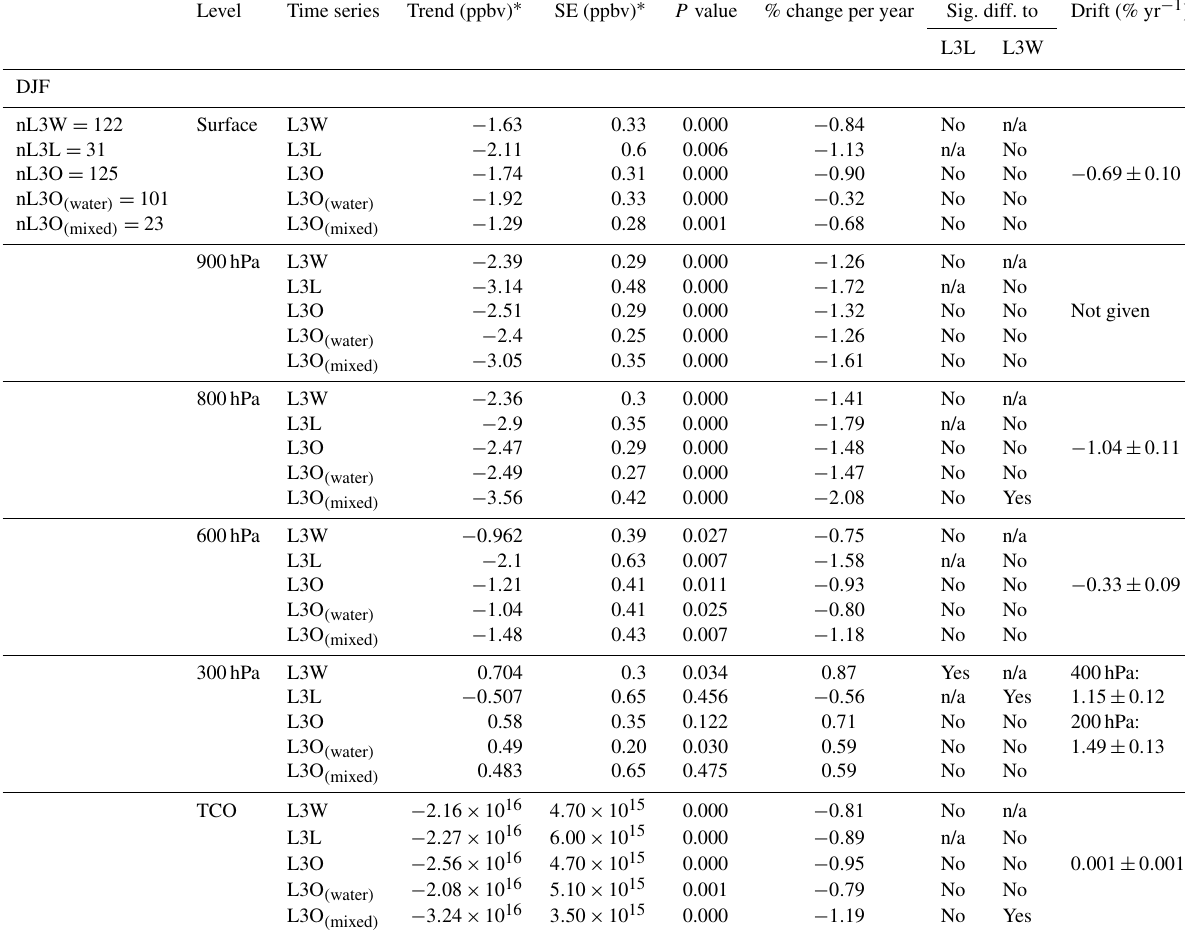
Table 3. Results from WLS regression analysis of seasonal mean L3W, L3L, L3O, L3O ( water ) and L3O ( mixed ) time series for selected profile levels in DJF and JJA. Trend corresponds to the gradient of the WLS best-fit line; SE is the standard error of the trend; P value is the probability that the trend is zero; % change per year is the mean percentage change in retrieved CO per year, calculated from WLS (cid:110)(cid:104)(cid:16) Predicted (cid:17) (cid:105) (cid:111)(cid:14) · 100 − 100 last regression model predicted values as follows: %change per year = ny , where ny is the number of years. Predicted first The penultimate two columns correspond to the result of a significance test performed on the difference between that row’s trend and the , where SE 1 and SE 2 correspond to the standard errors of Trend 1 and trend in L3L and L3W, respectively, as follows: Z = Trend 1 − Trend 2 (cid:113) SE 2 1 + SE 2 2 Trend 2 respectively, and Z is the test statistic. Where Z is greater (less) than 1 . 645 ( − 1 . 645), the trend difference is statistically significant to at least 90% (i.e. p < 0 . 1). Drift is the measurement drift values given in Deeter et al. (2017). No values are given for the 900 and 300hPa levels of the profile: we therefore cite values for the 400 and 200hPa levels to give context to the 300hPa trends we show; and we expect that the 900hPa level drift is somewhere between that of the surface and 800hPa levels, which are both